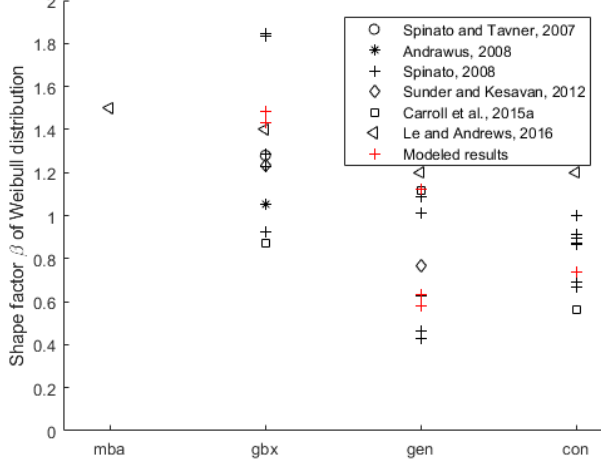
literature indicating ambiguous failure behavior. It needs to be considered that the Weibull shape factors are not distin- guished in the component design. Model results are com- ponent design specific and show different behavior for the different designs which is in line with literature values. This way the chosen distributions and distribution parameters are